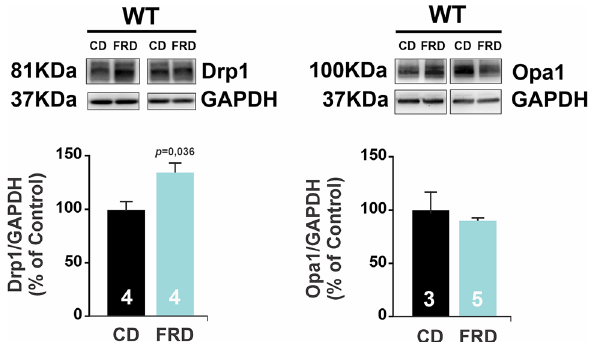
Figure 5. Prediabetes increases in fission protein expression in the heart. Representative immunoblots of Drp1 and Opa1, fission and fusion proteins, respectively, and average bar graphs. FRD WT mice heart has an increase in Drp1 but not in Opa1 expression with respect to CD